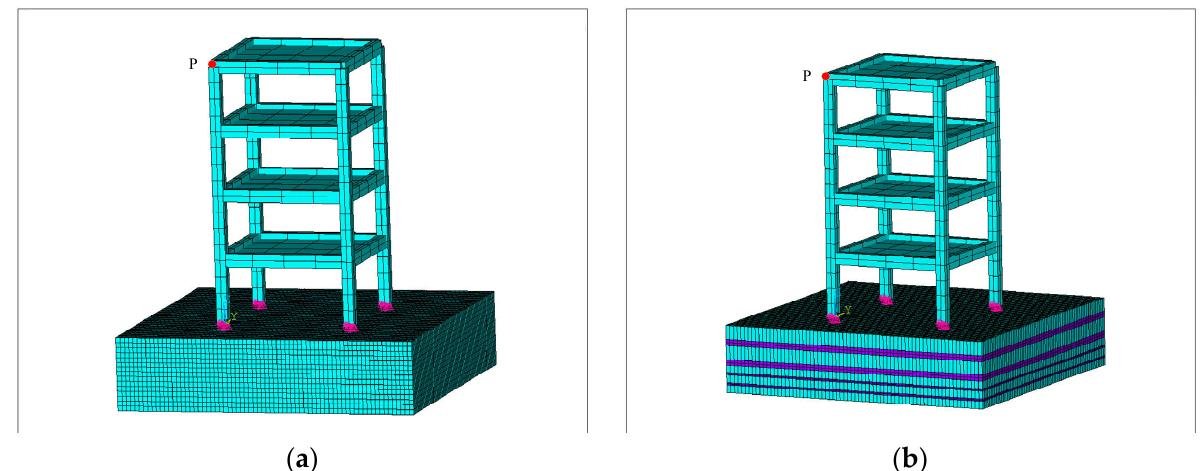
Figure 13. ( a ) Concrete foundation and ( b ) combined layered periodic foundation with superstructure.